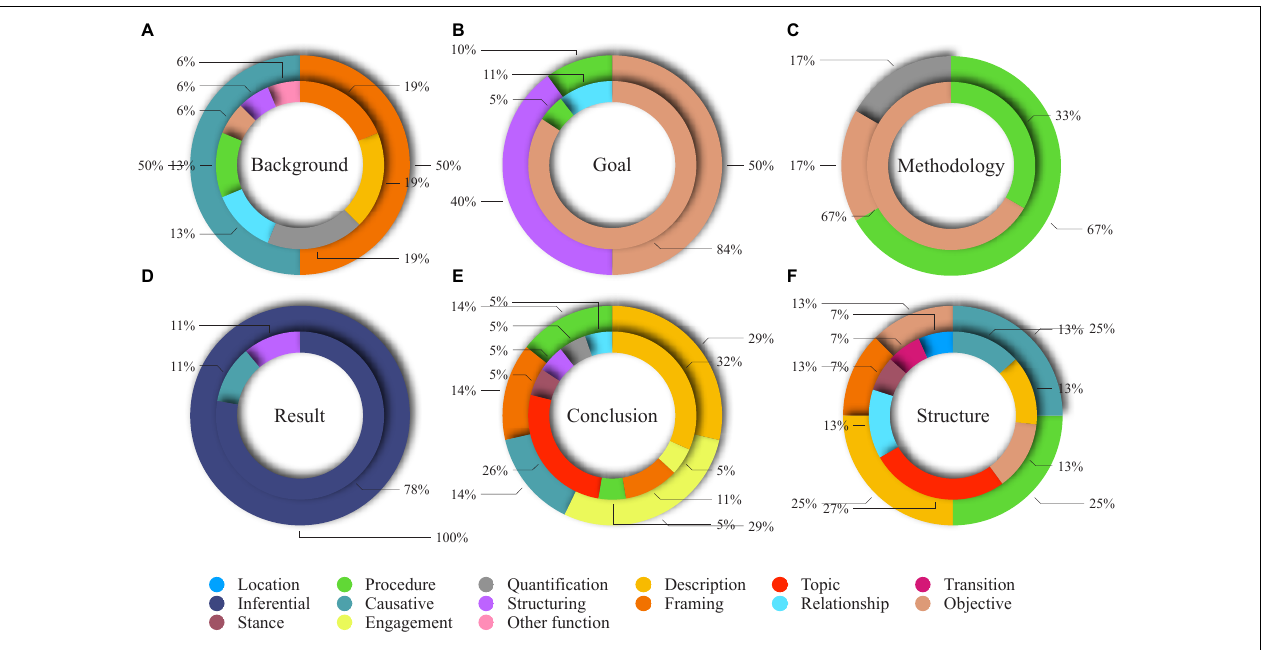
FIGURE 2 | Functional distribution of move-specific bundles in several communicative purposes (an inner circle: CUC; an outer circle: AUC; (A) introducing previous studies; (B) presenting purposes of research; (C) displaying research acts; (D) reporting results of research; (E) demonstrating beneficiaries of research; and (F) stating contents of